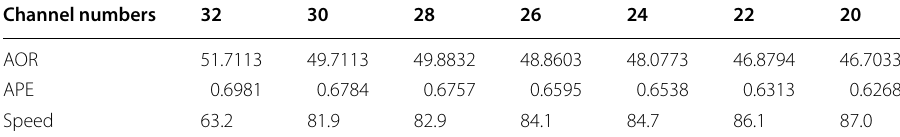
Table 2 Success and precision as well as speed on the OTB2013 datasets with different channels Channel numbers